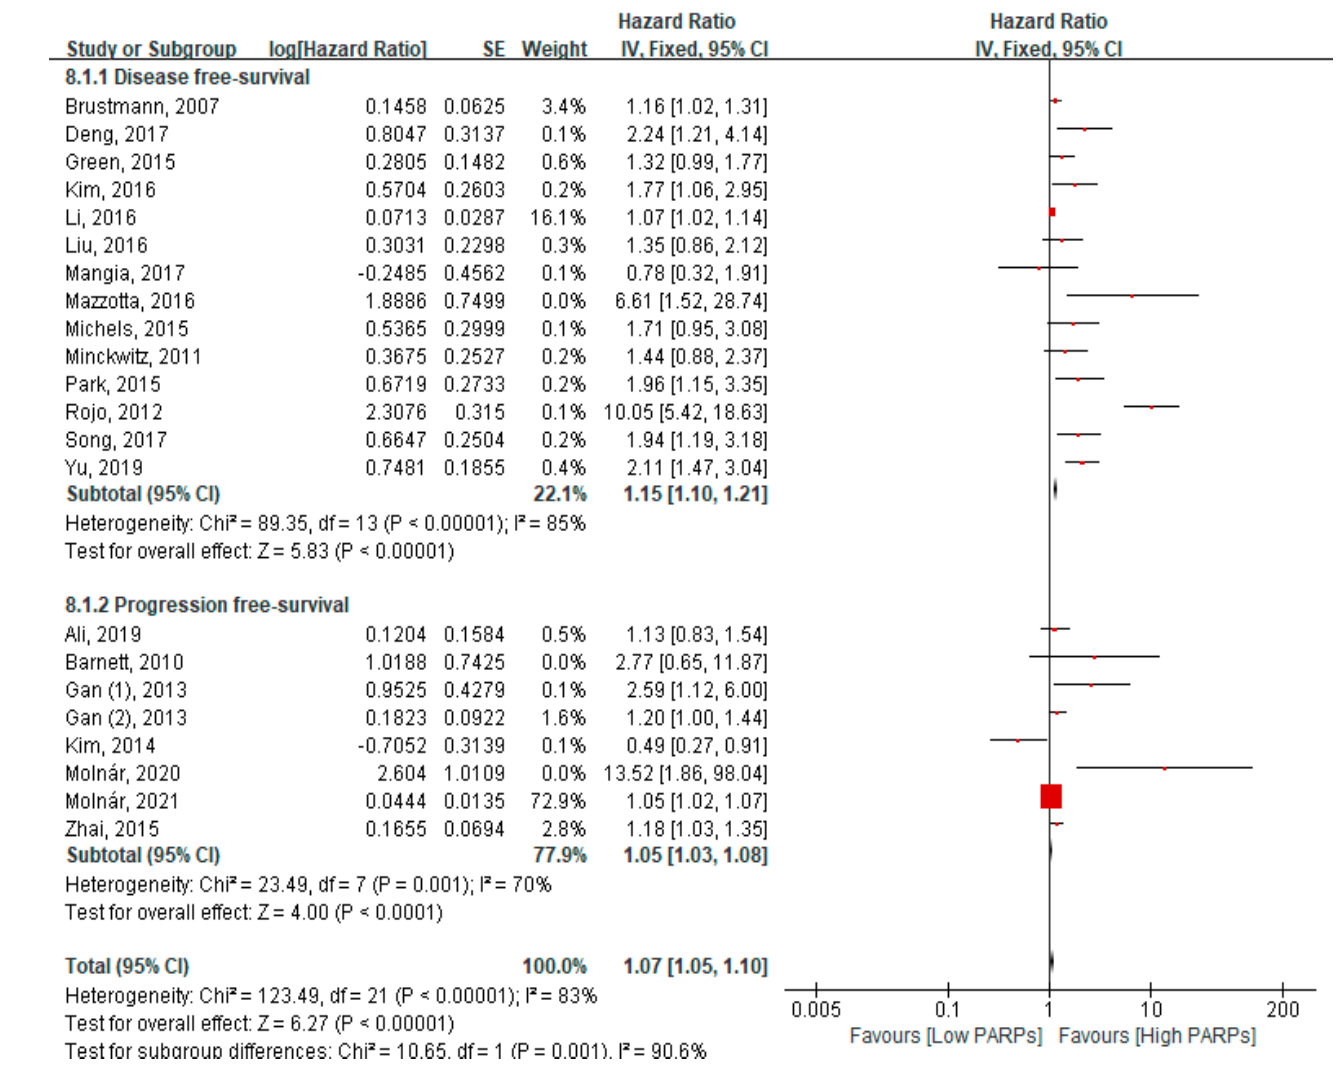
Figure 6. Forest plot of the hazard ratio for PARP expression and disease-free survival and progression-free survival in solid cancer patients.